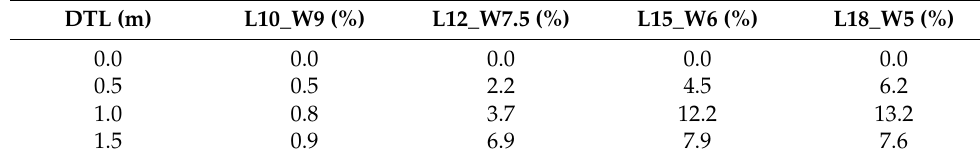
Table 4. Relative percent variation of the total